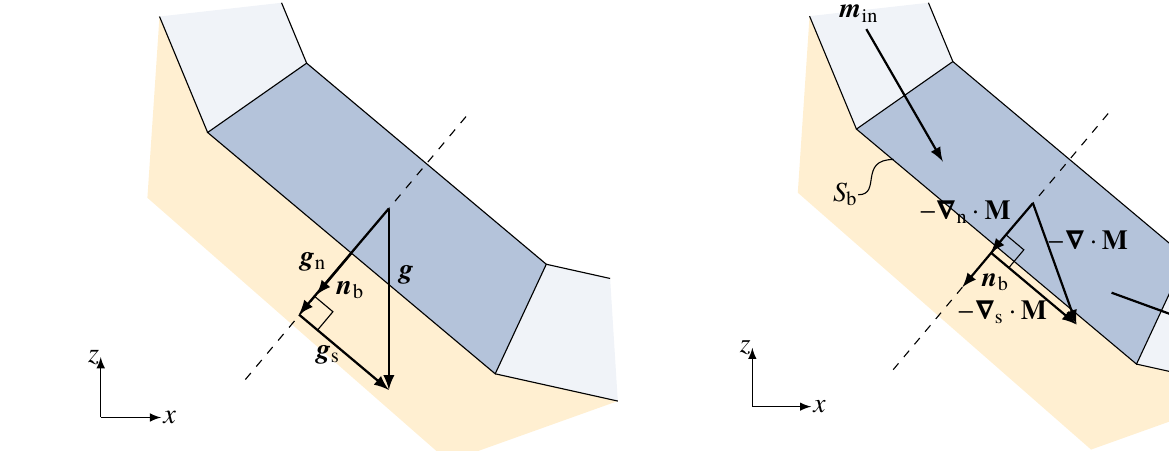
Figure A1. Splitting gravitational acceleration into a surface- tangential and surface-normal part with simple projections to the surface-normal vector n b .